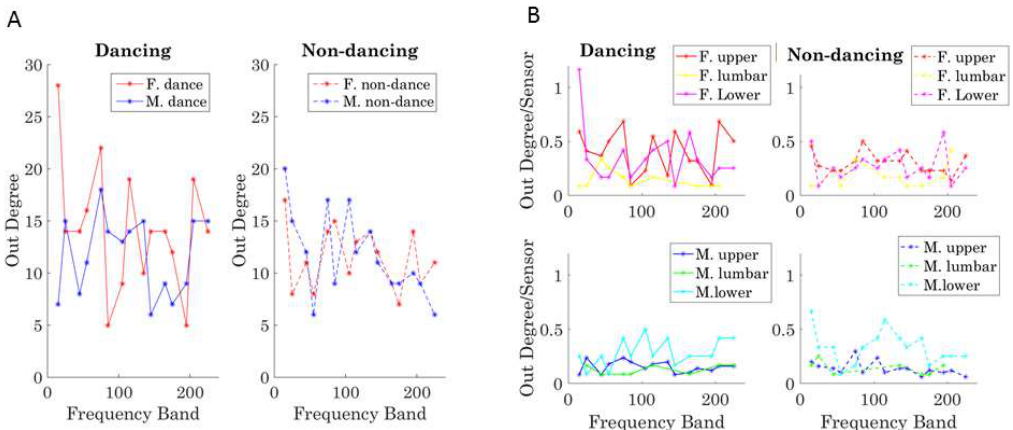
Figure 12. Automatically detecting patterns of leadership in the cohesiveness of the coupled behavior (inter-connectivity in ( A ) and intra-connectivity for each dancer in ( B ). ( A ) Leading patterns across the full network of spontaneously self-emerging coupled nodes across 10-based frequency bands. Patterns unveiled using the outdegree distributions and including cohesive activity in inter-connected nodes across the two dancers and ( B ) Leading activity for the self-emerging synergies of the body of each dancer (intra-connectivity). Out-Degree per node (sensor) used to unveil the leading information for selected body regions (upper body including the head, trunk, arms and hands), lumbar region (including lumbar areas and the hips) and lower body region (including the legs and feet) of each dancer. For the dancing condition in ( A ) the female tends to lead across frequencies with the male taking the lead for 90–100 Hz range. In contrast the non-dancing condition is primarily led by the male dancer, except in bands 90–100 Hz and 190–210 Hz. In ( B ) the individual patterns reveal which bodily region leads within each dancer’s synergies and condition, per frequency band.